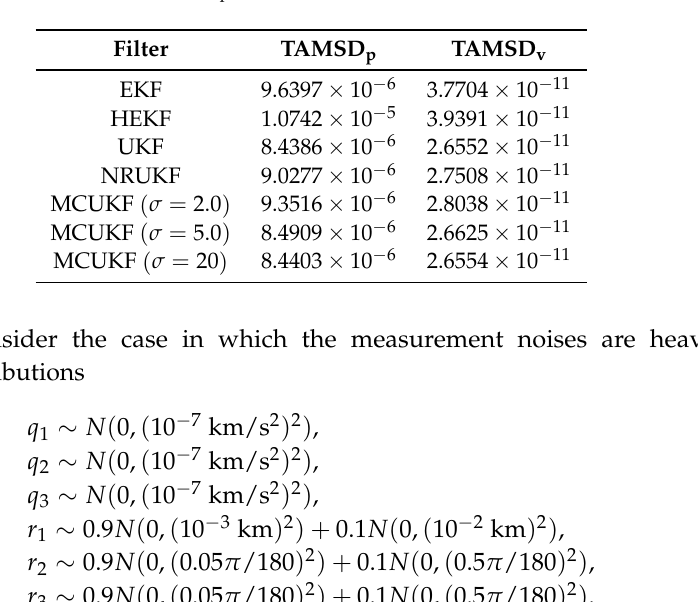
Table 4. TAMSD p and TAMSD v in Gaussian noises.